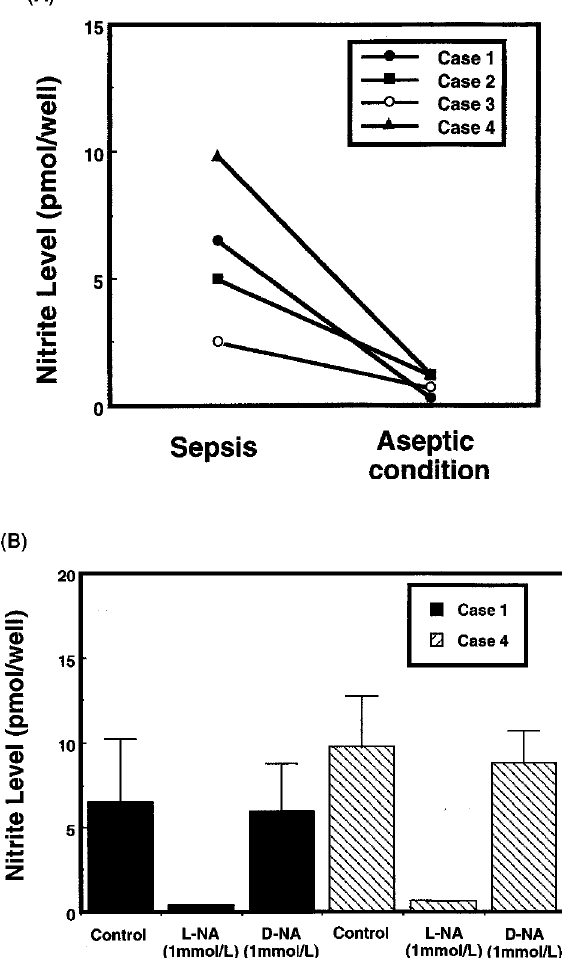
FIG. 1. (A) Nitrite production in vascular smooth muscle cells treated with serum obtained from the patients with sepsis. Vascular smooth muscle cells (SMC) were grown to con- fluence on a 24-well dish. Nitrite levels were measured in the medium of the SMC treated with the serum for 24 hours, as described in Patients and methods. Four patients (cases 1–4 in the Table 1) were analysed. The data represent the mean of 8 wells. (B) Effect of a nitric oxide synthase inhibitor, L-nitroarginine, on the nitrite levels in the SMC treated with serum obtained from patients with sepsis. Vascular smooth muscle cells (SMC) were grown to confluence on a 24-well dish. Nitrite levels were measured in the medium of the SMC treated with the serum for 24 hours, in the presence or absence of L-nitroarginine (1mmol/L) or D-nitroarginine (1mmol/L). These experiments were performed for Cases 1 and 4 described in Table 1. The data represent the means ±SEM of 8 wells. Each experiment was repeated 3